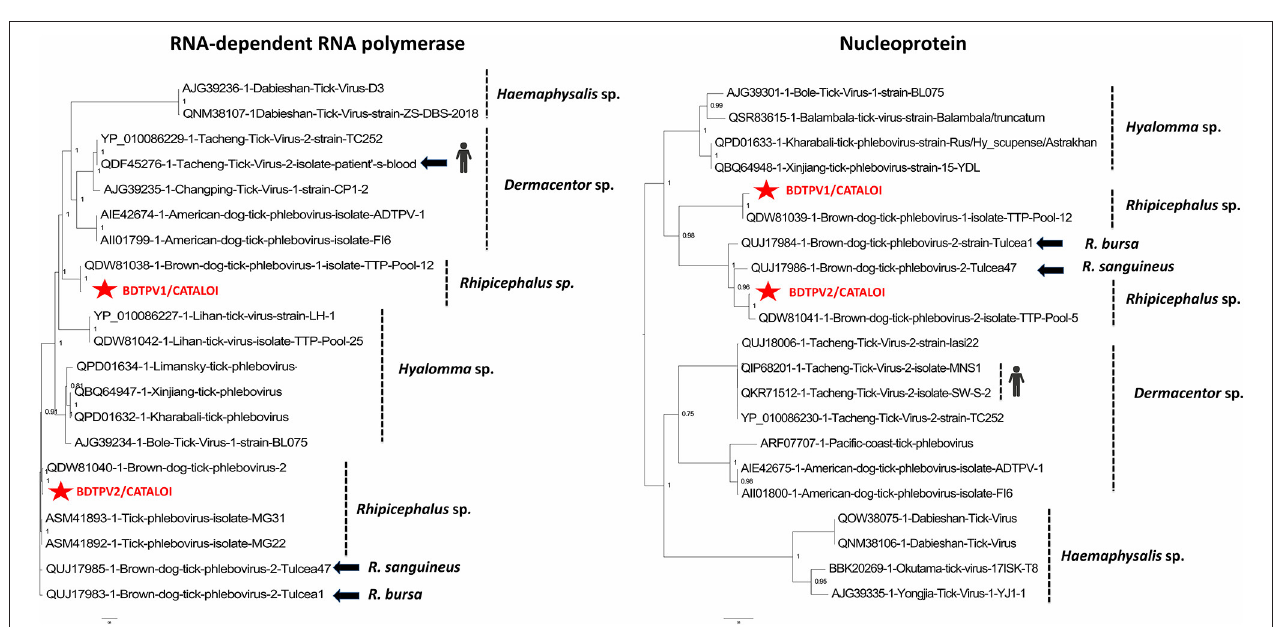
FIGURE 1 | Phylogenetic relationship of nucleoprotein and RNA-dependent RNA polymerase of BDTPV1 and BDTPV2 identified in Romanian Rhipicephalus ticks with other viruses among the Phlebovirus genus.